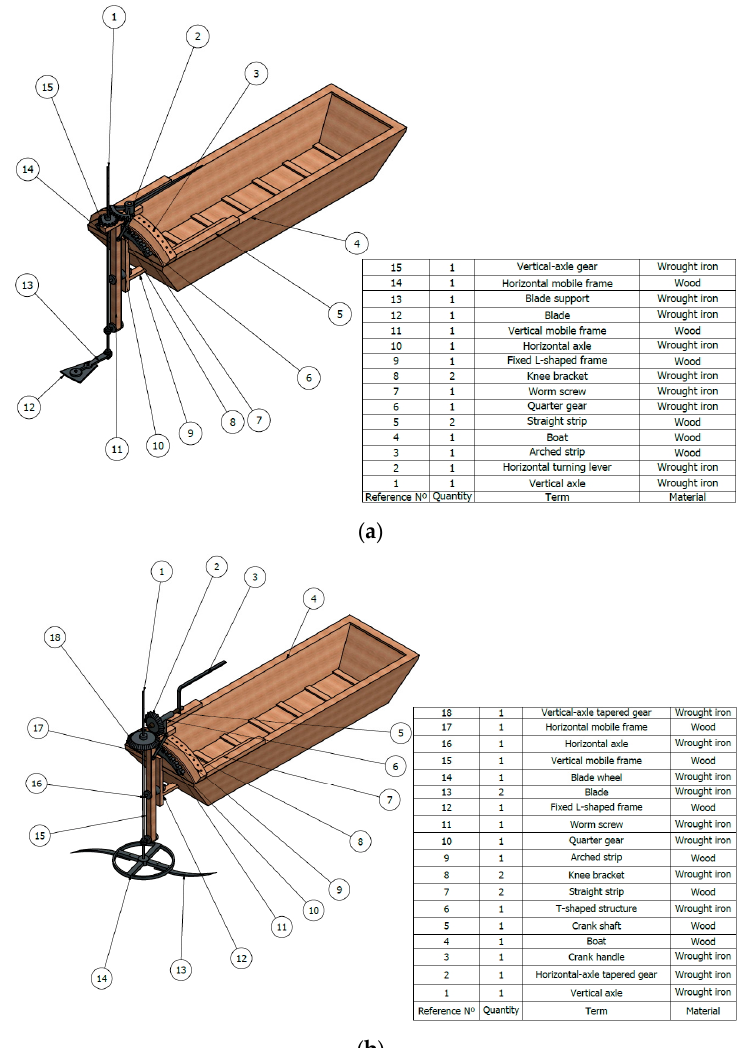
Figure 2. Plan of the ensemble with a list of different parts. ( a ) simple blade; ( b ) double blade.